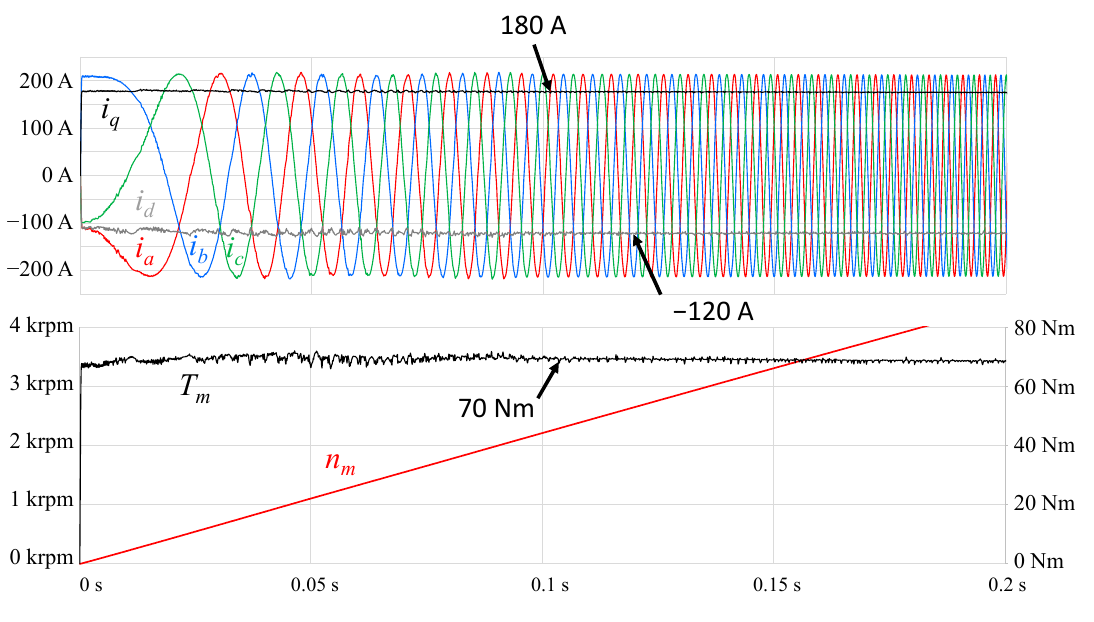
Figure 6. Simulation results of the control algorithm coupled with a 10 Nm load during start-up, representing the ( a ) stator windings’ currents ( i a , i b , i c , i d , i q ); ( b ) torque ( T m ) and speed ( n m ) of the SRPM machine.